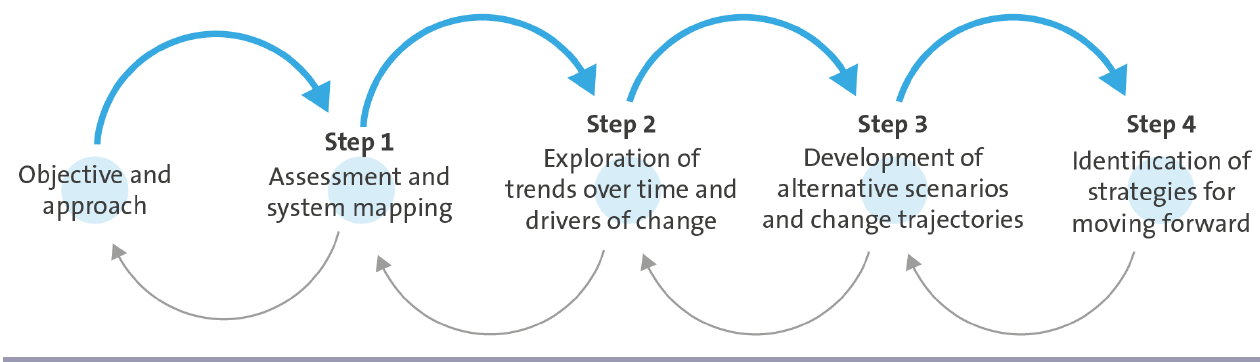
Fig. 2 . Outline of the stepwise iterative system exploration and knowledge